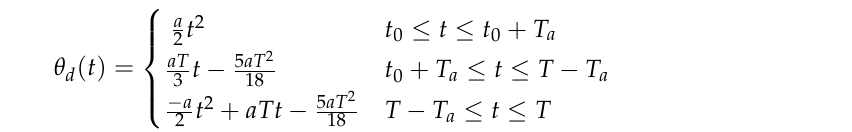
Figure 2. Trapezoidal velocity